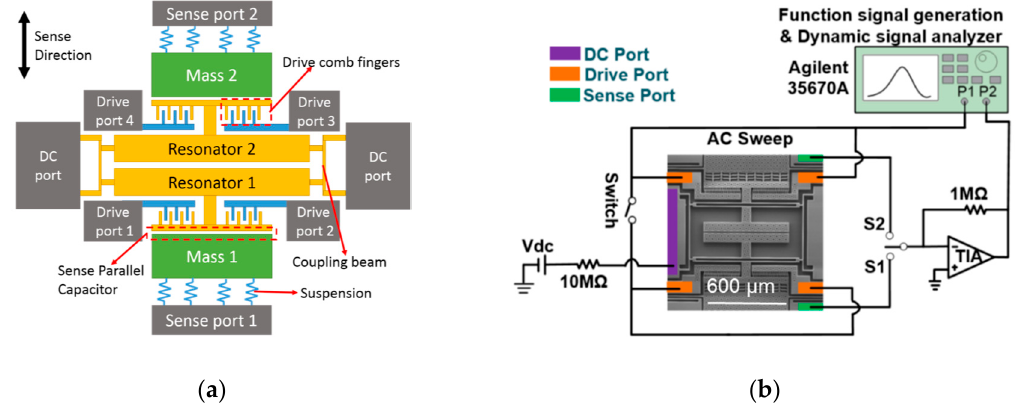
Figure 19. Schematic diagrams of 2DoF WCR accelerometer and its open-loop measurement setup developed by Zhang et al. at Northwestern Polytechnical University [110]: ( a ) a 2DoF WCR accelerometer; ( b ) open-loop frequency response measurement setup.